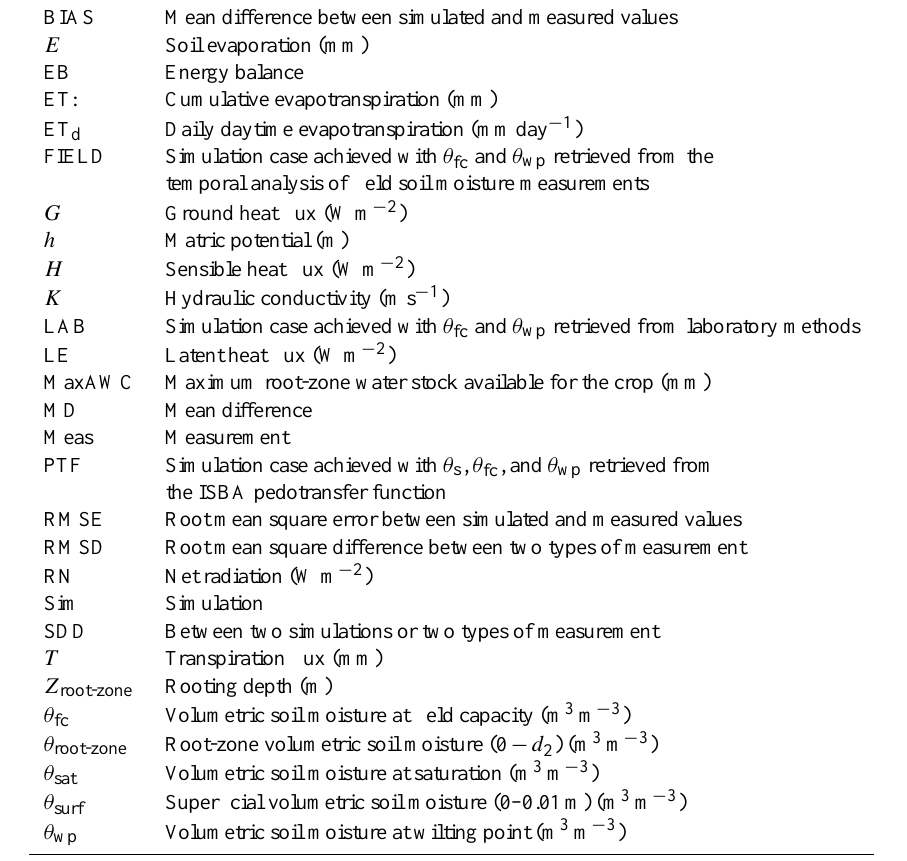
Table A1. Definition of the main